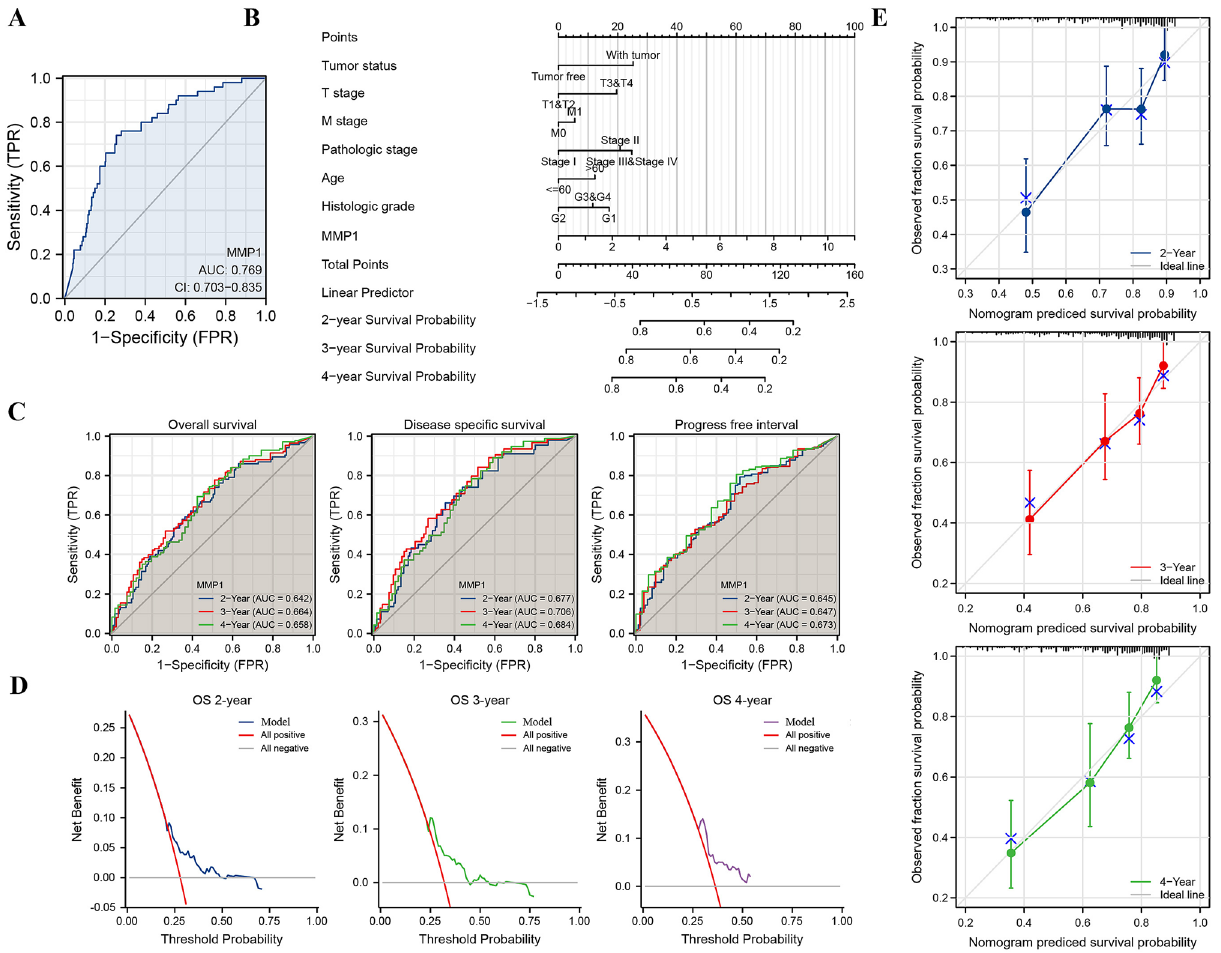
of TCGA-LIHC; ( C ) Time dependent ROC curve for verifying the utility of nomogram; ( D ) Decision curve analysis for evaluating the prognostic model; ( E ) Nomogram calibration